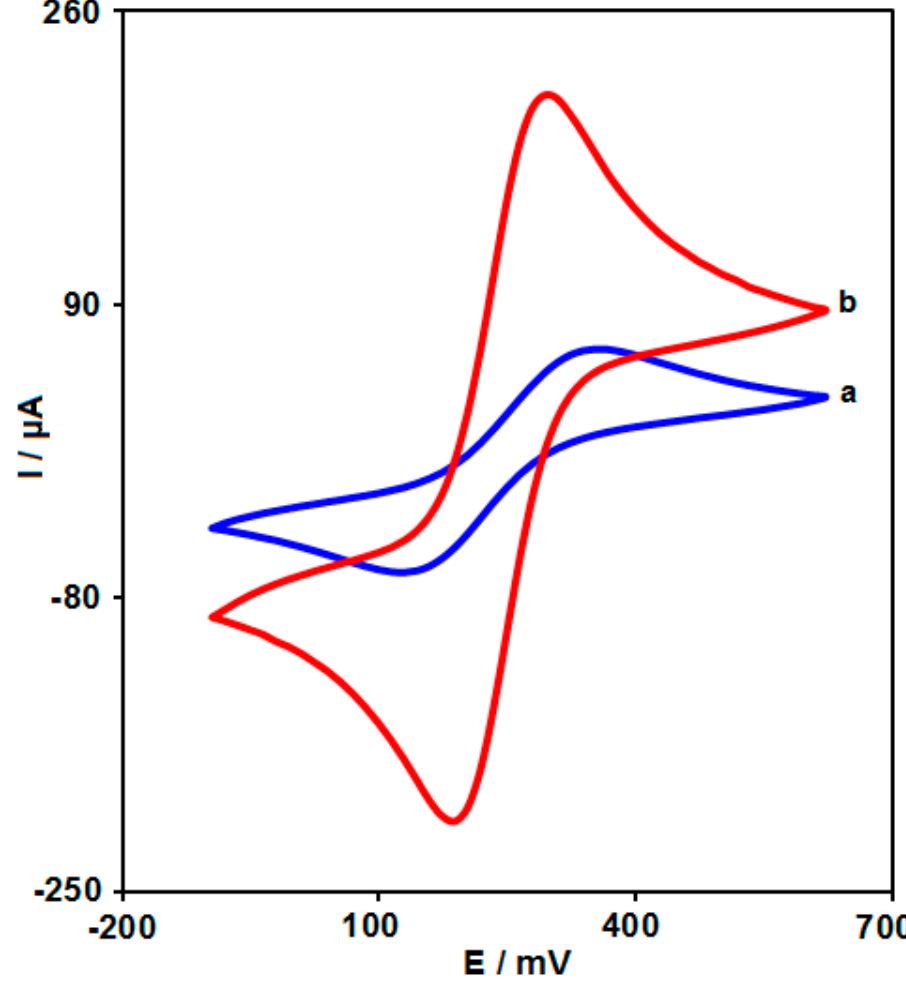
Figure 5. CVs curves of different electrode in PBS (0.1 M, pH 7.0) solution containing 1.0 M KCl and 5.0 mM Fe(CN)6 3-/4- ; (a) bare SPGE and (b) NiCo 2 O 4 /SPGE. Scan rate: 100 mV s − 1 .